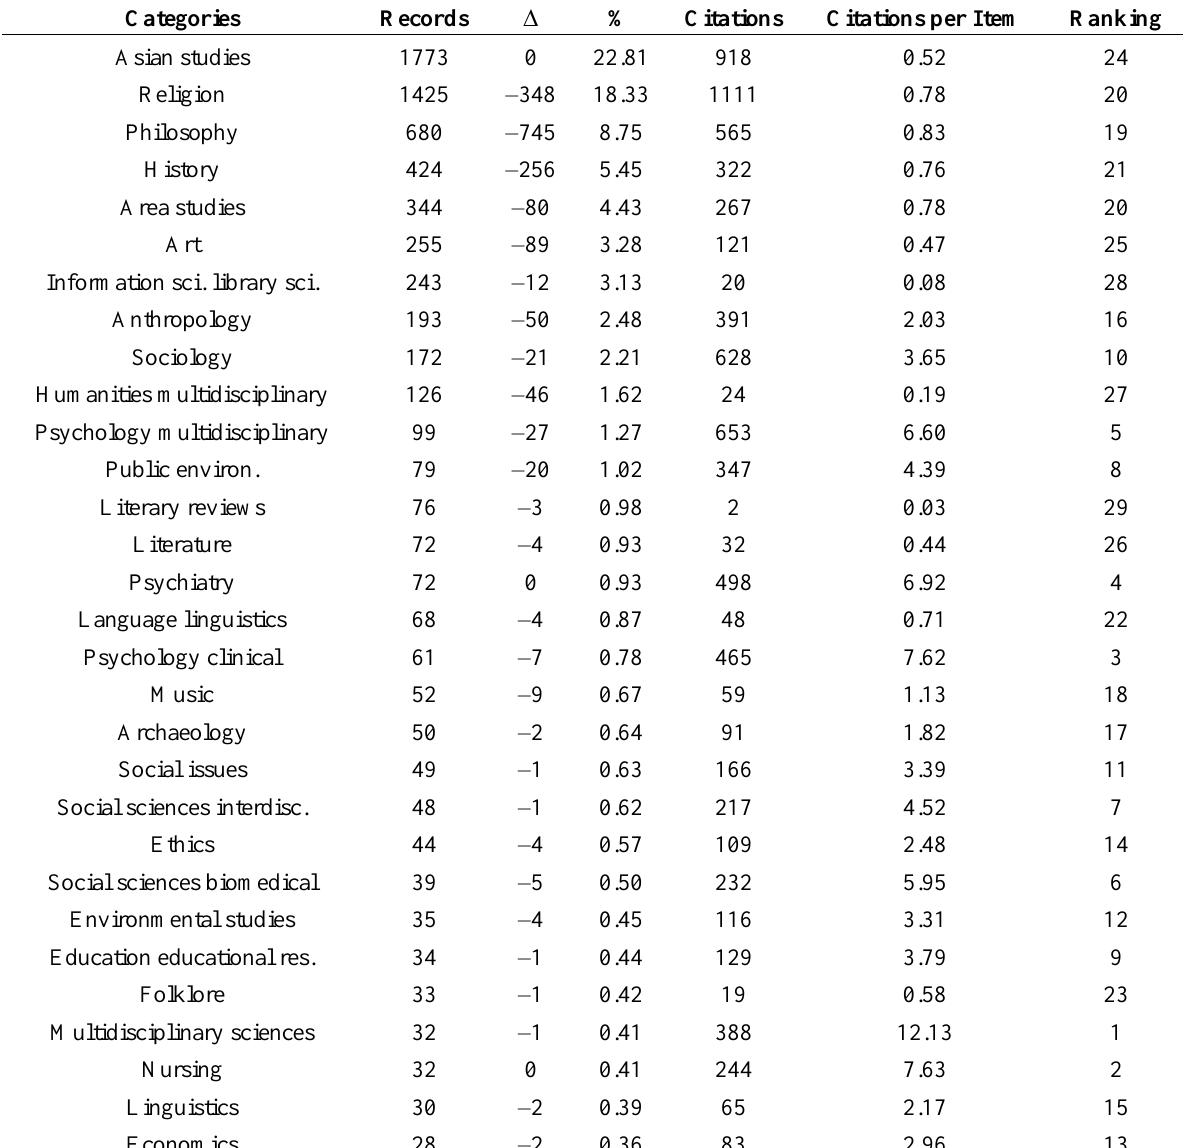
Table 6. List of the top 30 WoS categories with the greatest number of scholarly scholarly